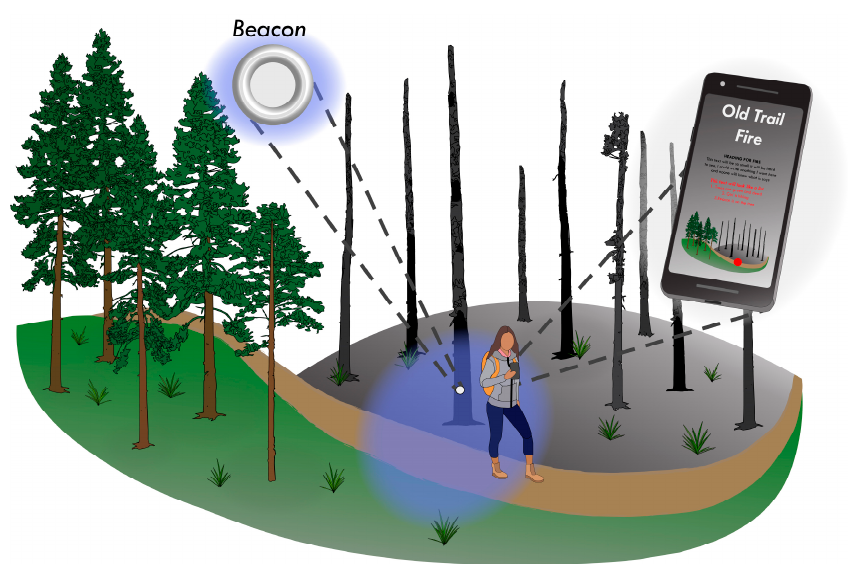
Figure 11. In location-based service applications for mobile devices, proximity to Bluetooth beacon signals trigger the sharing of information provided in smartphone applications. Mobile applications may also then develop metrics based on how many users have passed a beacon location, or modify information provided based on a sequence of actions taken by users as they interact with multiple beacons. LBS can also base information on geographic coordinates (GNSS) or proximity to map-based features.